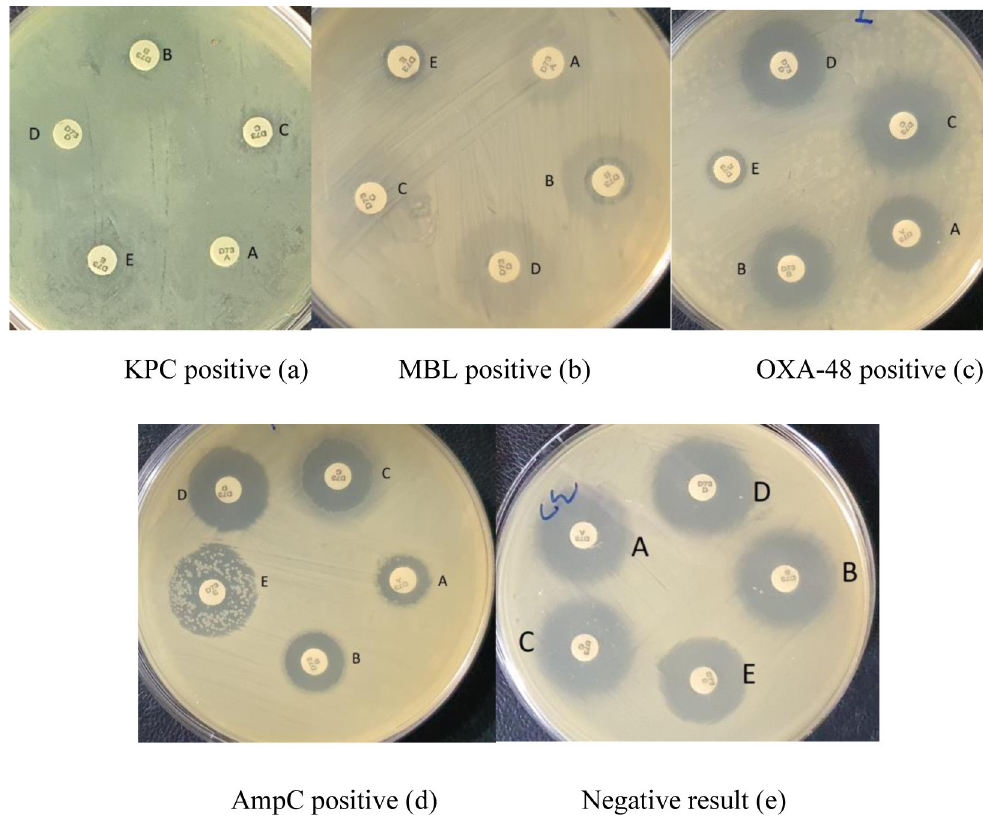
Fig 1. Positive results for MBL, KPC, OXA-48, and AmpC + porin loss isolates for carbapenemase-producing, and a negative result for non-carbapenemase-producing Gram-negative bacilli isolates detected by Carba plus assay. The difference in disc zone diameters was observed between disc A (faropenem), disc B (MBLs inhibitor), disc C (KPC inhibitor), disc D (AmpC inhibitor), and disc E (temocillin in combination with MBLs inhibitor). The positive result is shown for isolates that possess KPC, disc C- disc A � 5 mm and the difference between each disc B- disc A and disc D- disc A < 5 mm (a). The positive result of MBL having isolate shows that disc B- disc A � 5 mm and difference between each disc C- disc A and disc D- disc A < 5 mm (b). OXA-48 positive result showing that there is no increased zone on disc A- disc B, disc C, or disc D, respectively, and disc E � 10 mm (c). The positive result of AmpC with porin loss shows that there is a � 5 mm difference in both discs D and C zone diameter compared with disc A ( < 5 mm difference between disc B and disc A) (d). Negative results for non-carbapenemase-producing Gram-negative bacilli display that the diameter of the inhibition zone of all discs varies by � 2 mm, and disc E > 10 mm